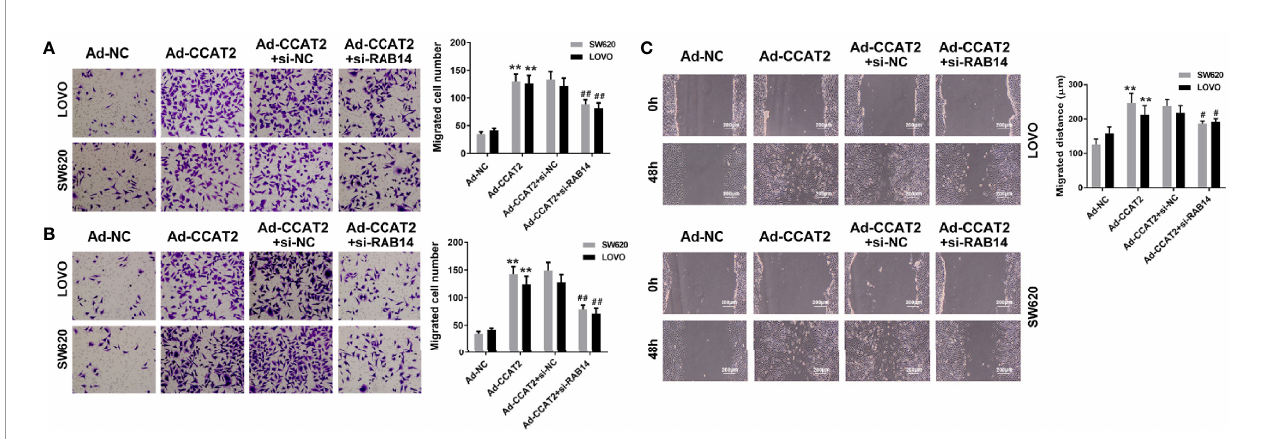
FIGURE 6 | RAB14 knockdown inhibited the migration- and invasion-enhancing effects of CCAT2 on colorectal cancer cells in vitro . (A, B) Transwell (cell invasion and migration) assays and data quanti fi cation (×400). (C) Wound healing assays and data quanti fi cation (×400). The data are represented as mean ± SD. Three independent biological repeats were used for each analysis. **P < 0.01 vs Ad-NC, # P < 0.05, ## P < 0.01 vs